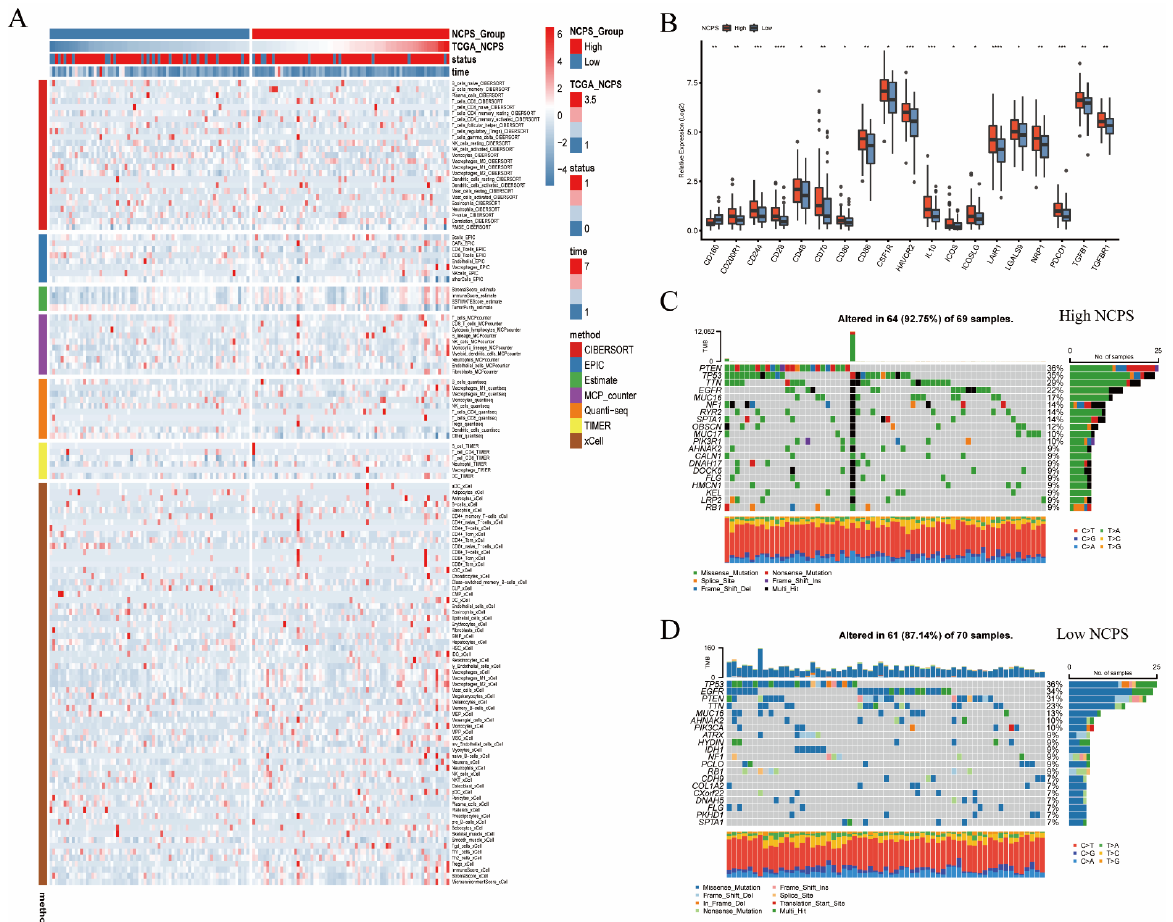
Figure 5. Immune infiltration analysis and mutation landscape. ( A ) Heat map of immune cell infiltration in the high NCPS group and low NCPS group. ( B ) Expression of immune checkpoint-related genes in the high NCPS group and low-NCPS group. The results showed that the expression trend of immune checkpoint-related genes was higher in the high NCPS group. ( C ) Mutation landscape of TCGA cohort in the high-NCPS group. ( D ) Mutation landscape of TCGA cohort in the low-NCPS group. * p < 0.05; ** p < 0.01; *** p < 0.001; **** p <